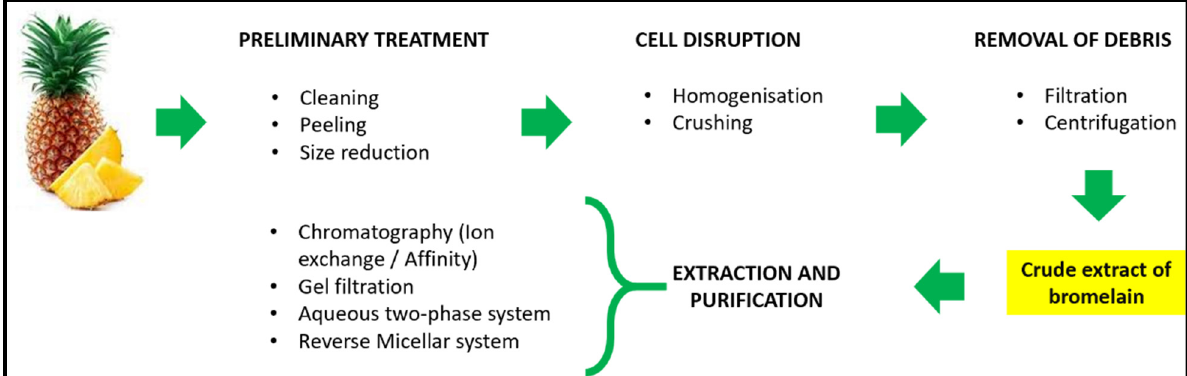
Figure 1. Overview of bromelain extraction and purification methods. Conventional approach: centrifugation, ultrafiltration and lyophilisation.